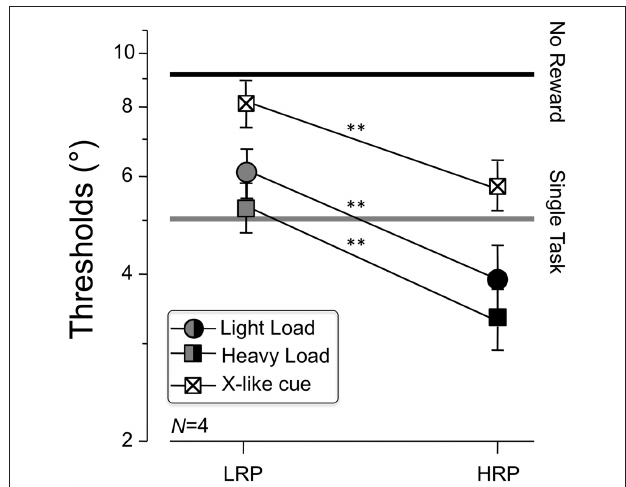
Figure 2 | Average orientation discrimination thresholds ( N = 4), corresponding to the 75% correct point of the psychometric function. The points represent the different reward rates (LRP, gray, and HRP, black) and different symbols represent different attentional conditions (light load, circles; heavy load, squares; X-cue, crossed squares). The straight horizontal lines marks the average orientation discrimination threshold for the peripheral target alone in the absence of attentional loading task (gray line, bottom) and for the dual task without reward (black line, top). Plotted data include only the analysis of trials in which the central task was successful (accurate counting). Error bars plot the SEM. The order of conditions (blocks) was shuffled throughout the experiment for all but the Heavy Load condition, executed later as a control experiment, which explains the slight (but not significant) reduction of thresholds (that leaves the pattern of results unaffected). Rewarding correct orientation discrimination responses, though as rarely as in 10% of the cases, sets performance of the main tasks to a level comparable to when there was no central task, whereas highly frequent rewards show an additional advantage of the same magnitude (about a factor of 1.5, p < 0.01). In the presence of an X-like cue thresholds are slightly higher for both reward rates, which may be due to a sub-optimal use of the cue. Importantly, the modulation of performance obtained by increasing the reward probability is of the same amount across attentional load sand cue types, suggesting that the effect cannot be explained by the use of spare attentional resources allocated to the peripheral task. Notice that the absolute value of threshold is high as discrimination is performed around the oblique axes, where orientation coding is rougher (Campbell et al.,